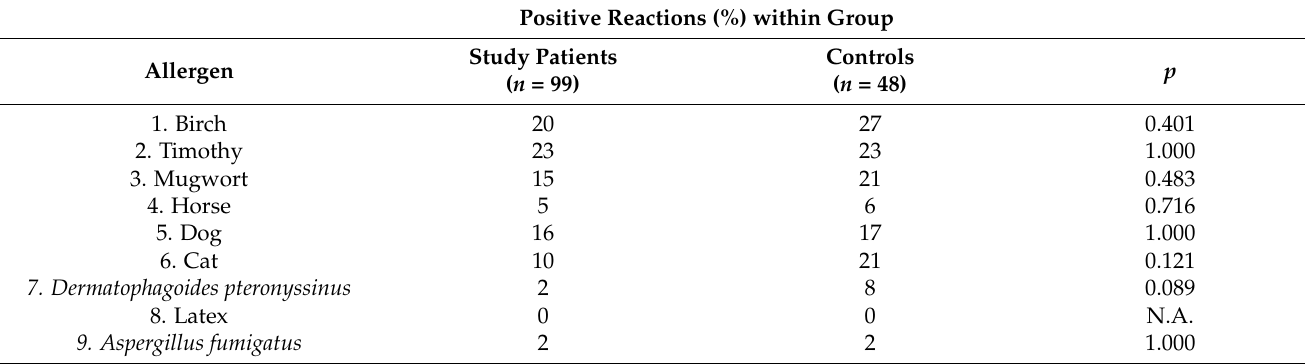
Table 2. Positive reactions to specific allergens in skin prick tests of the study patients and the